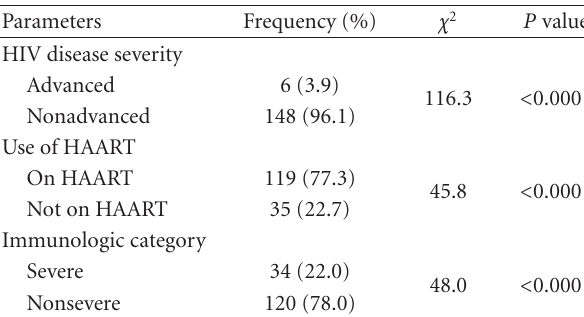
Table 1: General characteristics of the subjects.